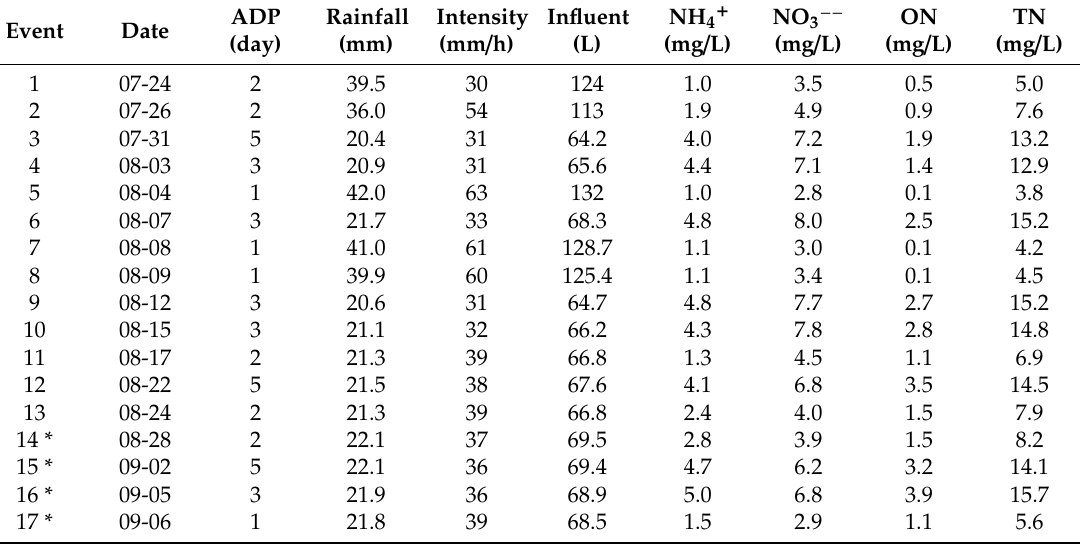
Table A1. Artificial simulation stormwater runo ff events.